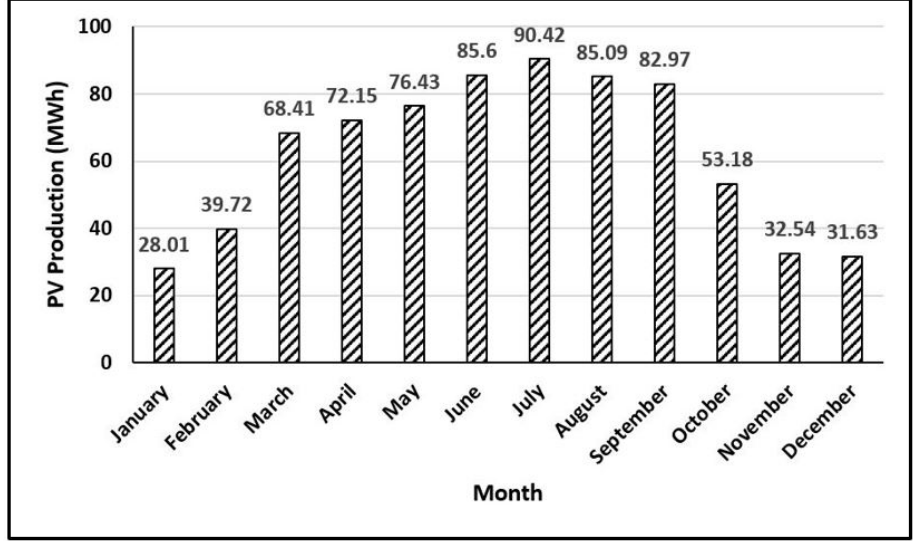
Figure 6. Maximal daily PV production per